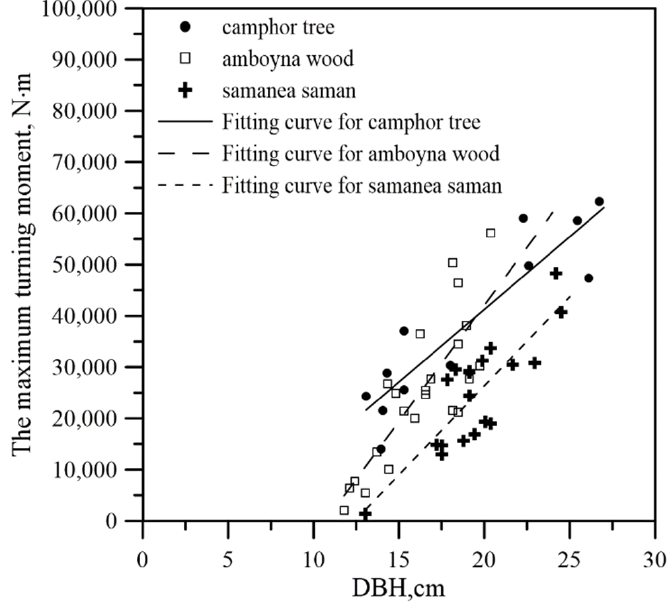
Figure 5. The maximum resisting moment vs. DBH for different tree species in near-saturated soil conditions. Table 4. Regression equations for the relationship between TM max and DBH in near-saturated soil conditions.